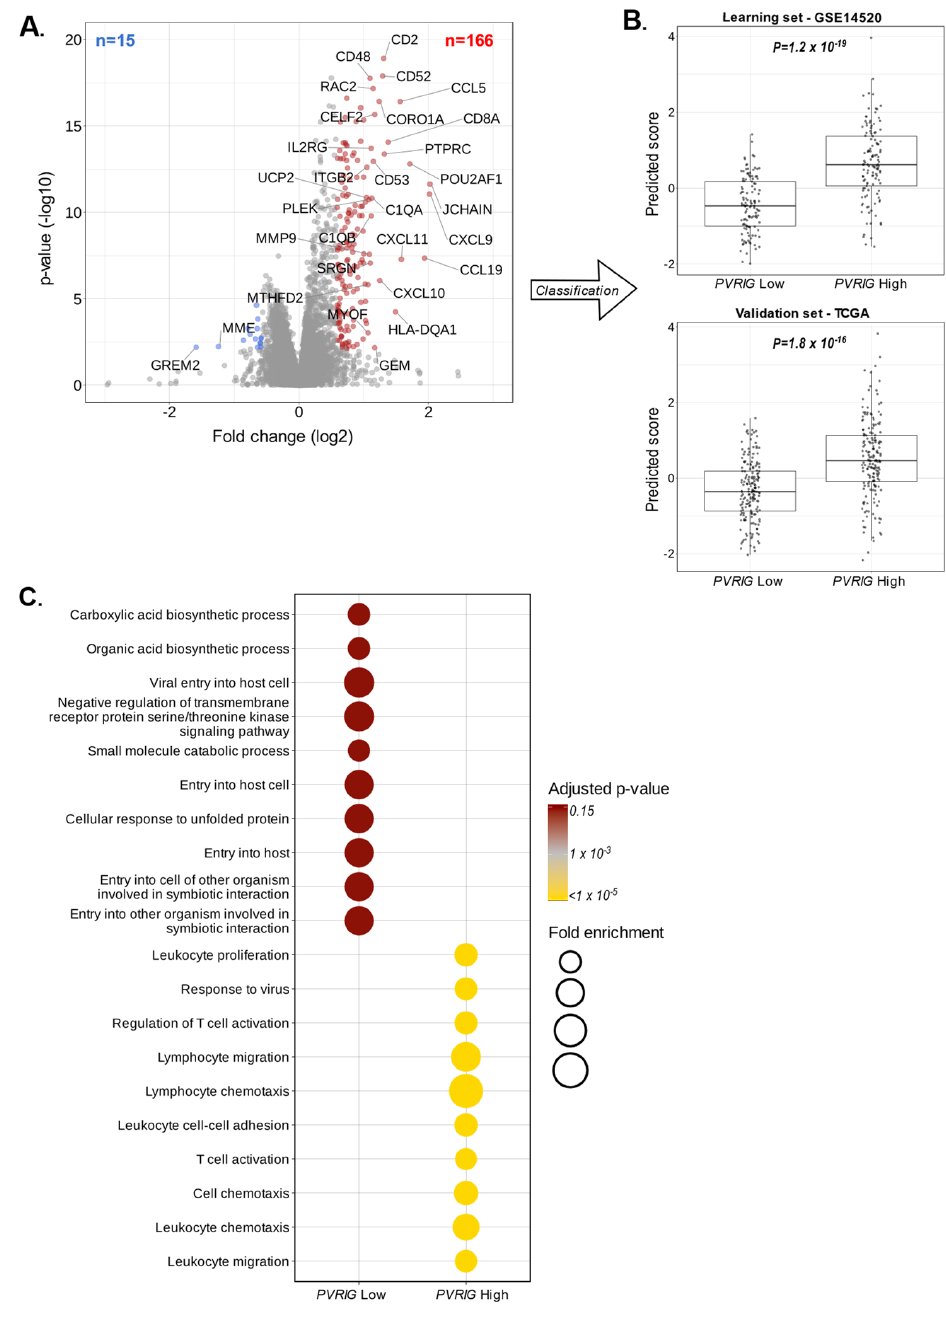
Figure 5. Correlations of PVRIG expression with biological processes: ( A ) Volcano plot of the 181 genes differentially expressed in the learning set (GSE14520, n = 242), with downregulated genes in PVRIG Low tumors ( left , blue) and upregulated genes in PVRIG High tumors ( right , red). PVRIG (x = 0.60; y = 38) is out of the scale. ( B ) Validation of robustness of the 181-gene list by comparing the metagene scores of PVRIG Low samples and PVRIG High samples using a Student t-test in the independent validation set (TCGA, n = 360). ( C ) Gene ontology (GO) enrichment analysis of 181 genes differentially expressed between PVRIG Low and High groups in the learning set (GSE14520, n = 242).